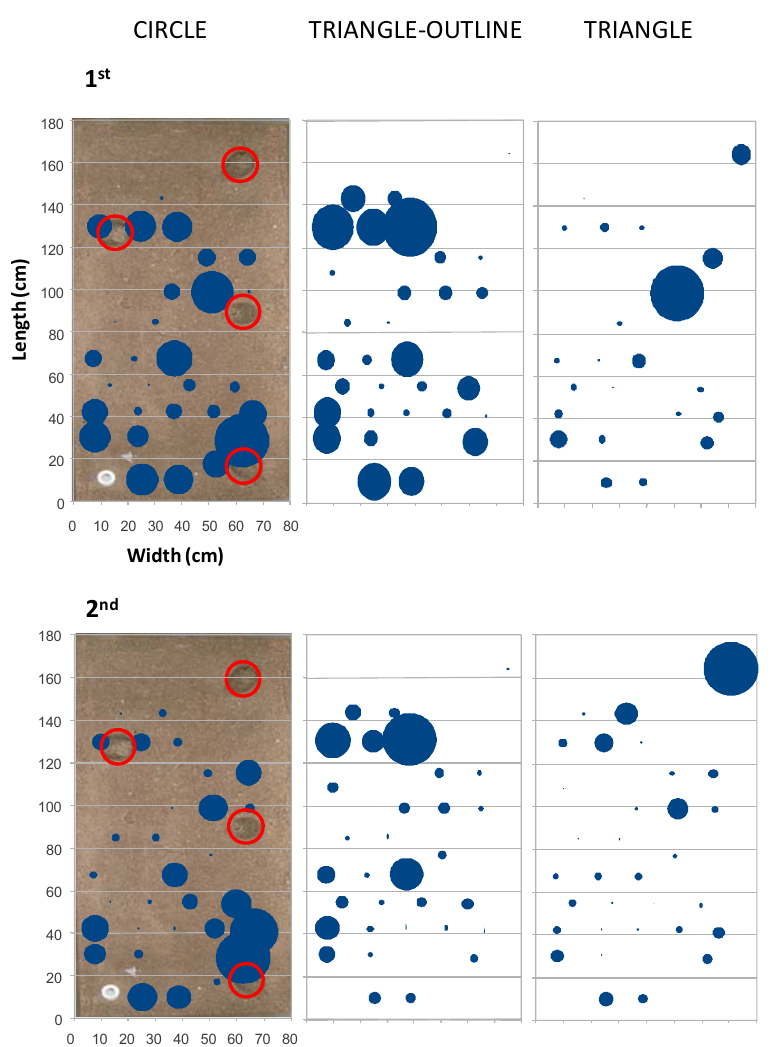
Figure 7. Inter-individual differences in the occupied areas of a group of three Nephrops , detected using RFID tracking during the first (1st) and second (2nd) day-night experiment. The blue circles are proportional to the percentage of occupation, computed from the cumulative detections in each antenna field over the duration of the experiment. The red circles indicate the entrances of the four tunnels, with their location superimposed onto a picture of the tank area for which the length and width coordinates have been also reported as a system of x , y coordinates, see Figure 1(C). CIRCLE TRIANGLE-OUTLINE